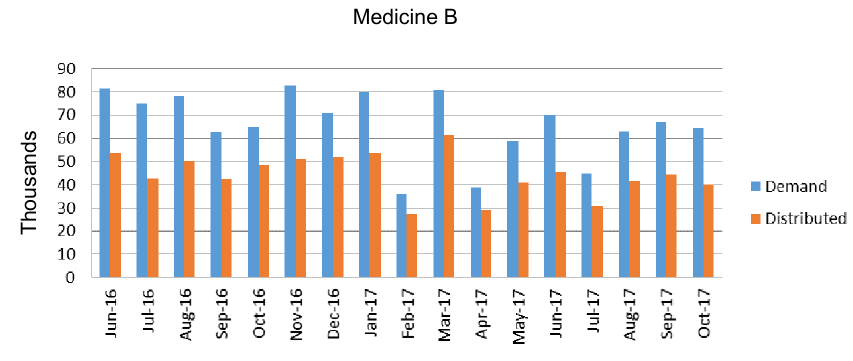
Fig. 2. Medicine B demand behaviour.